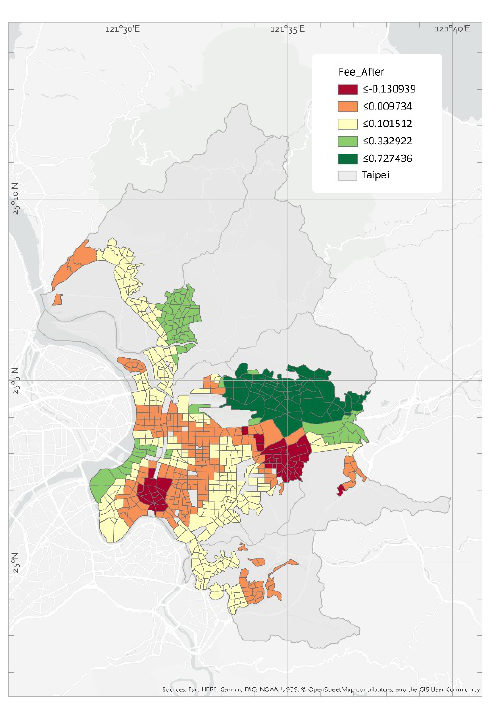
Figure 4. Coefficient of Curb Parking Fee (After Policy